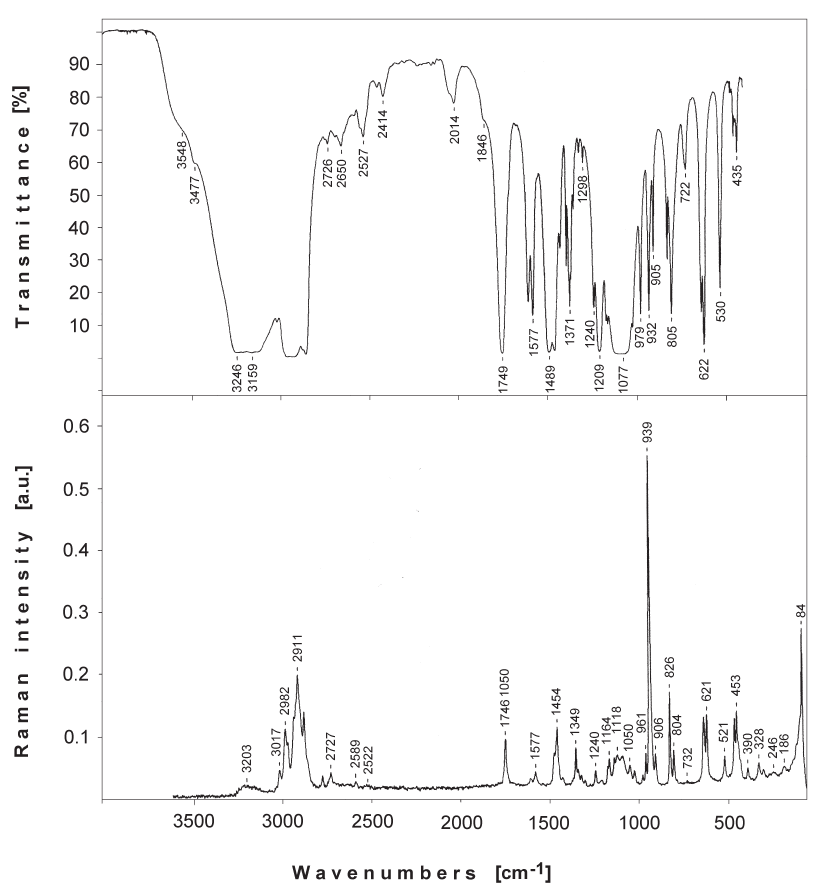
Figure 4. Room temperature powder FTIR (top) and FTRaman (bottom) spectra of L-leucinium perchlorate crystal.